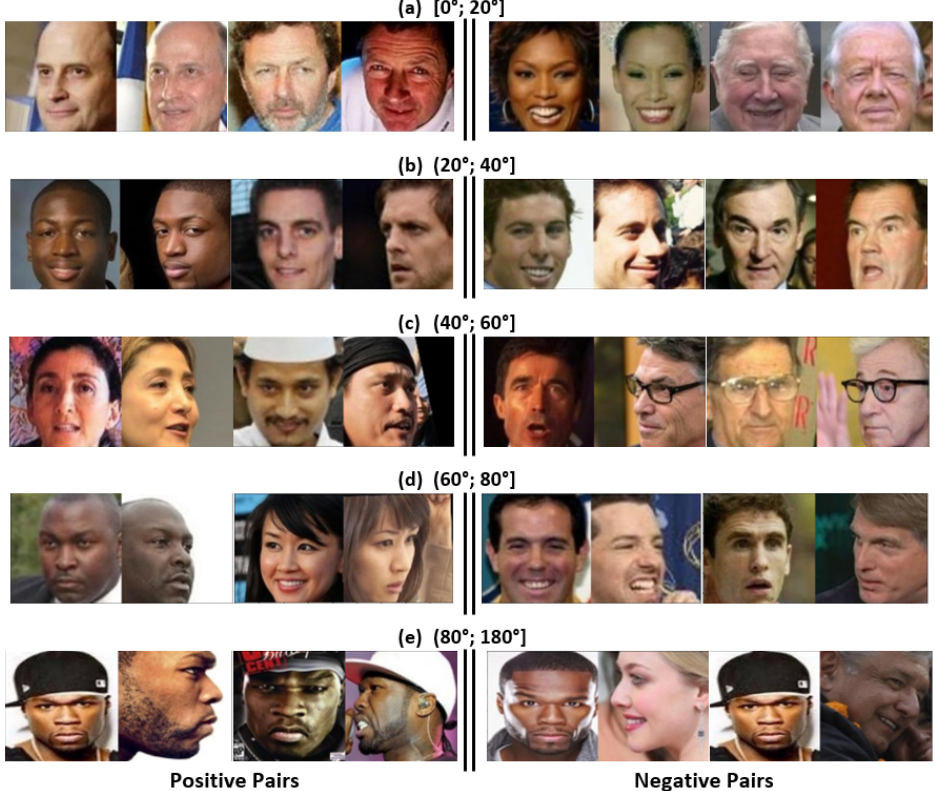
Figure 4. Examples of the pairs chosen for the proposed evaluation